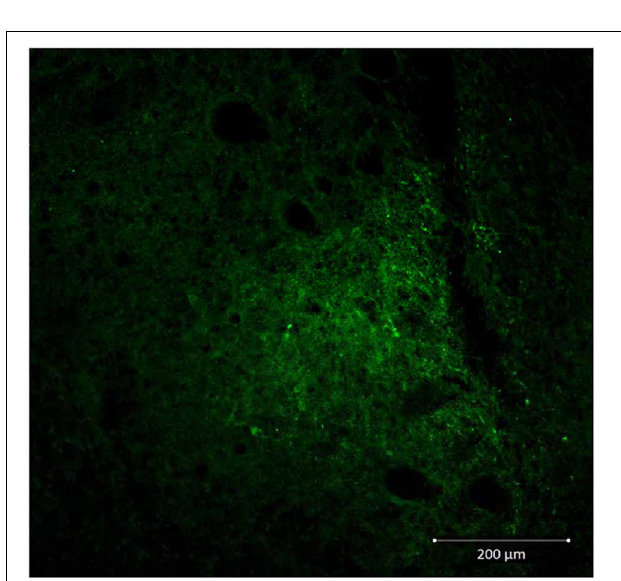
FIGURE 2 | Representative image (20X) showing injection needle tract in CeA of a siControl injected animal. CRF neurons are labeled in green.